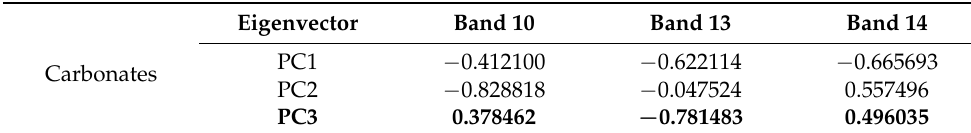
Table 5. Eigenvector matrix of the carbonates calculated using SPCA method for ASTER bands 10, 13, and 14 o.